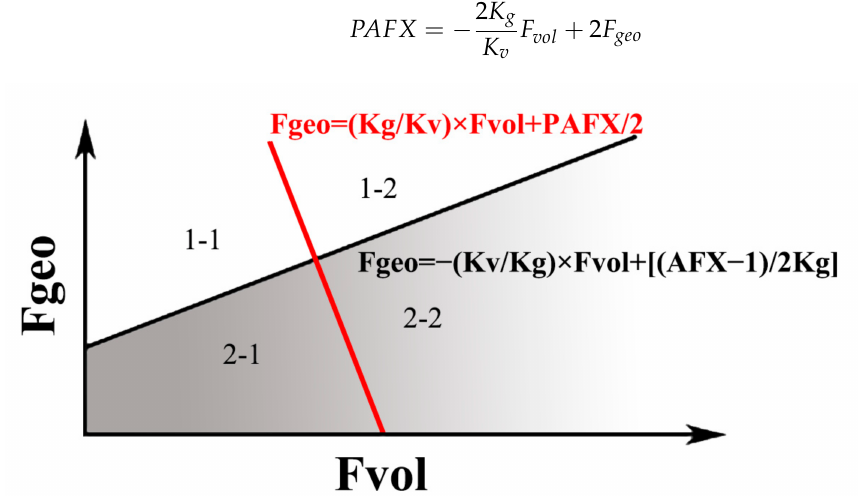
Figure 2. The relationship between the two indices in parameter space. The region name rule is the category index number when each of AFX and PAFX is classified independently; for example, A1P1 means that the region belongs to the first category of AFX and the first category of